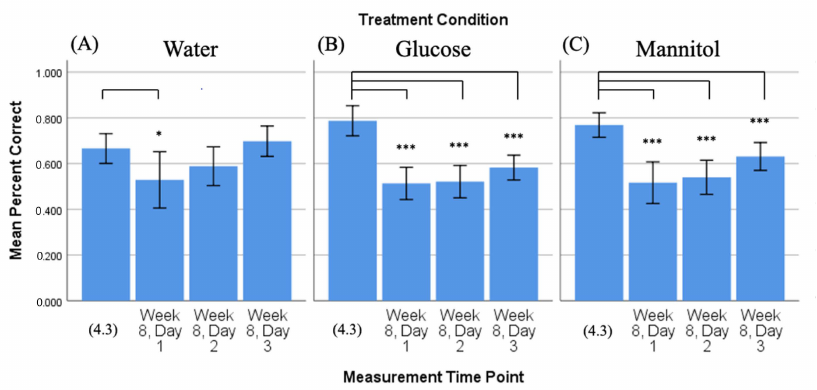
Figure 3. Comparison of 4-week vs. 8-week reversal. Mean percent correct scores (+/ − 95% CI) calculated on 4-week reversal day 3 (4.3) were compared to scores calculated on all three 8-week reversal days for ( A ) water-treated, ( B ) glucose-treated, and ( C ) mannitol-treated fish using individual t -tests. Water-treated fish showed an improvement in scores over the three 8-week reversal days, indicating they were able to learn the new location of the shoal reward. In contrast, glucose- and mannitol-treated fish had significantly lower numbers of correct scores on all three 8-week reversal days (day 1 p < 0.001, day 2 p < 0.001, day 3 p ≤ 0.001), suggesting these fish were unable to learn the new location of the shoal reward. * and ***: Asterisks denote significant differences.